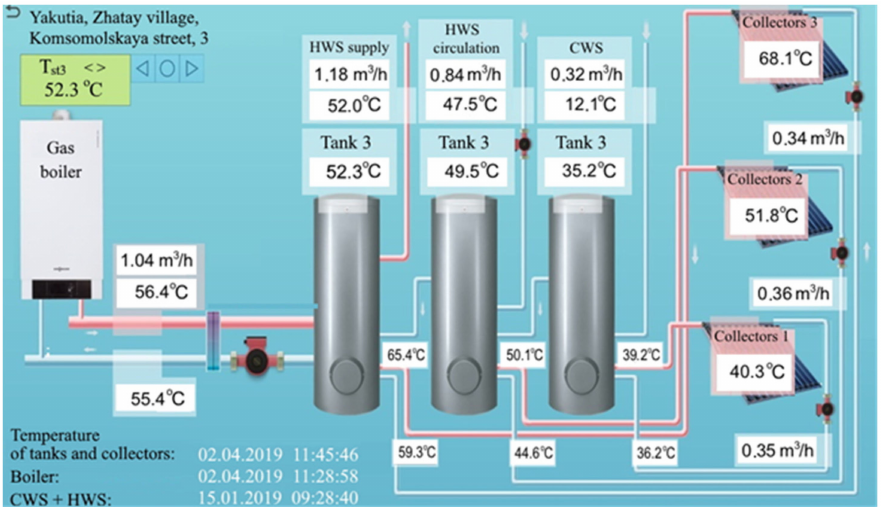
Figure 3. Mnemonic diagram of the hardware and software application for field studies of the solar hot water system of a residential building on 3 Komsomolskaya St. in